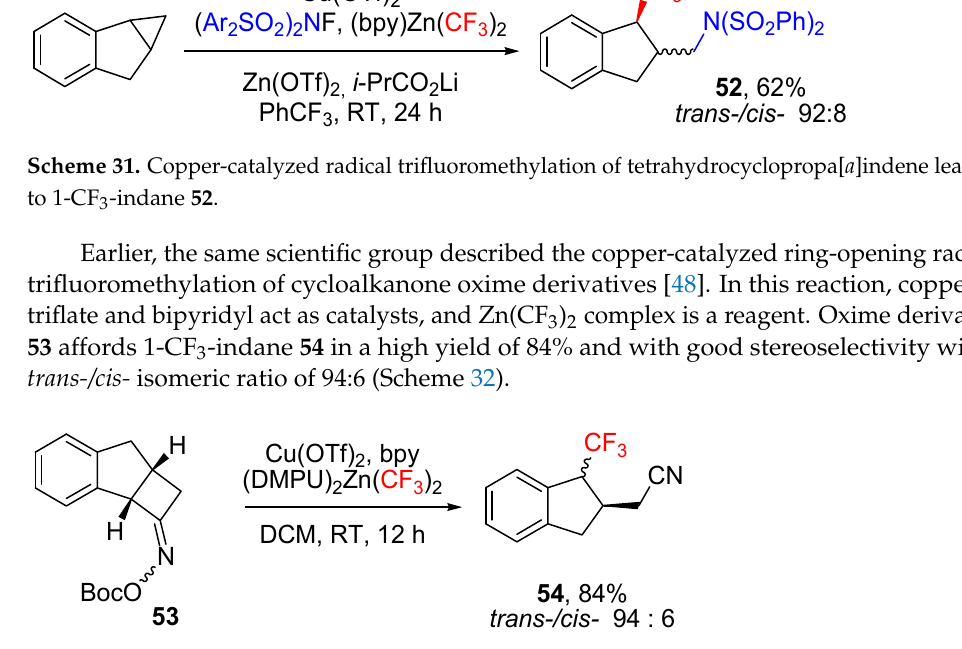
Scheme 32. Copper-catalyzed radical trifluoromethylation of compound 53 leading to 1-CF 3 -indane 54 .